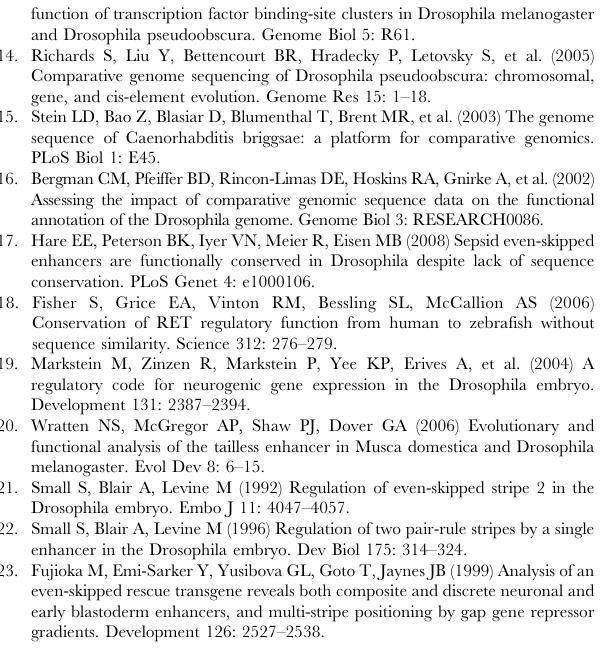
Table S2 Genome size and sizes of orthologous region types of Drosophila species relative to D. melanogaster